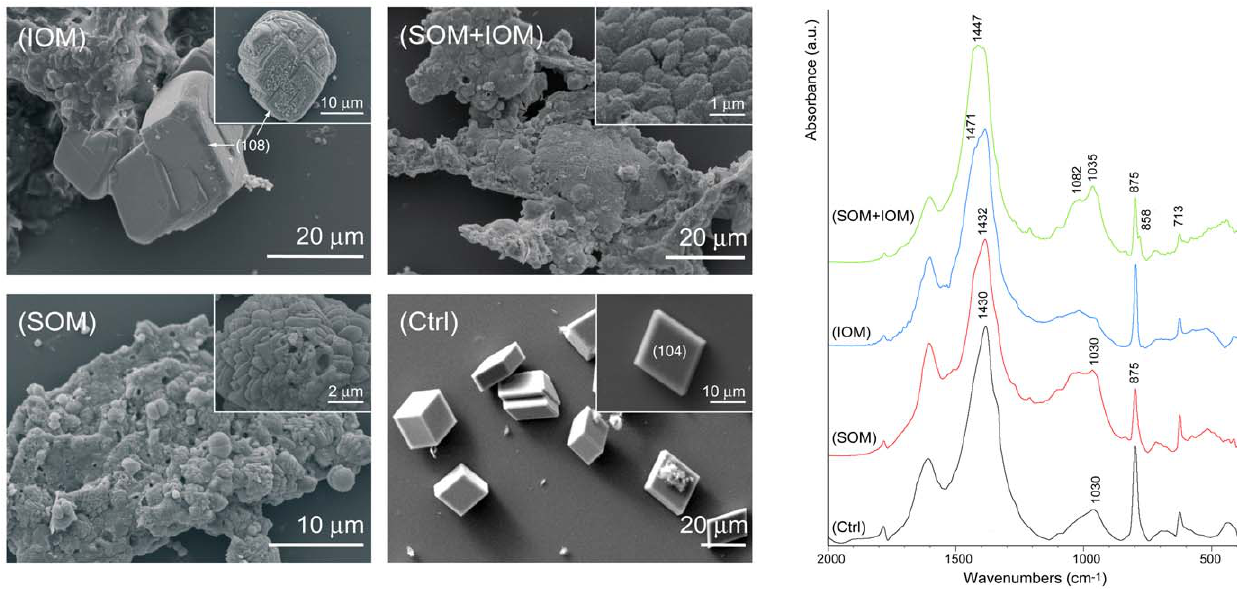
Figure 5. Calcium carbonate crystallization experiments. Crystallization experiments of calcium carbonate from 10 mM CaCl 2 solution in the absence of additives (Ctrl) and in the presence of soluble organic matrix (SOM), insoluble organic matrix (IOM) or both additives (IOM + SOM). The Miller indexes of calcite faces are indicated. left Scanning electron microscope images, the insets show sample details. right FTIR spectra of the precipitated. The main absorption bands of calcium carbonate are indicated.